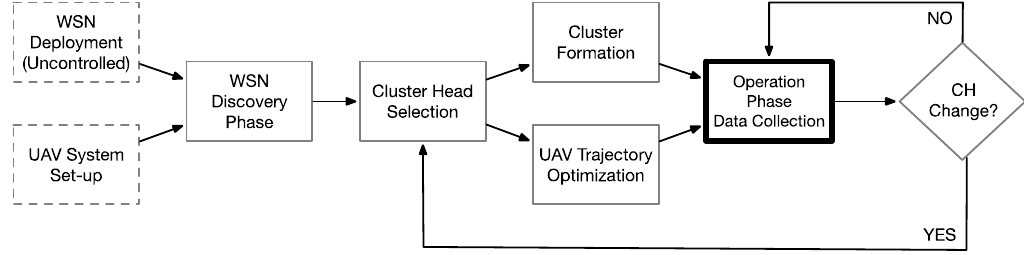
Figure 2. Hybrid UAV-WSN large scale monitoring functional diagram.